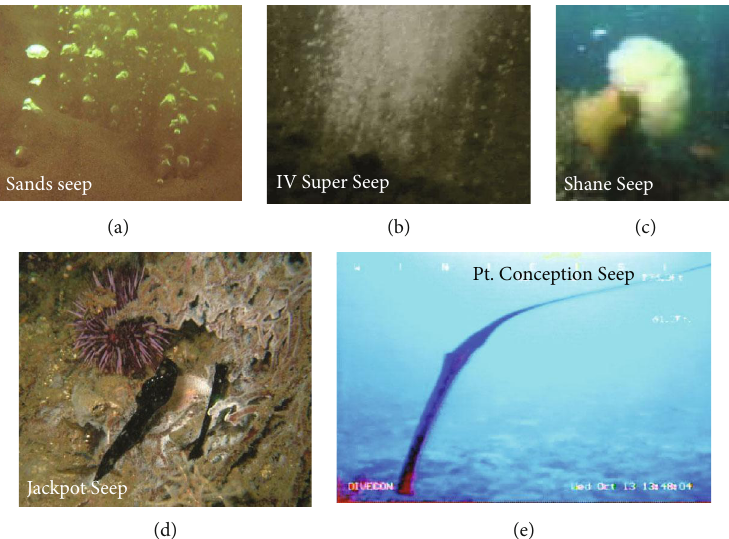
Figure 5: Example images of (a) mobile sediment seepage including many minor bubble plumes, (b) a megaseep where emissions arise from numerous vents that combine into a single bubble plume, IV Super Seep, (c) obstructed seep that leads to bubble aggregation into very large bubbles from Shane Seep, and (d) oil seepage from Jackpot Seep in 10 m water depth. From Leifer [39]. (e) Tar whip from o ff Point Conception. From Lorenson et al.